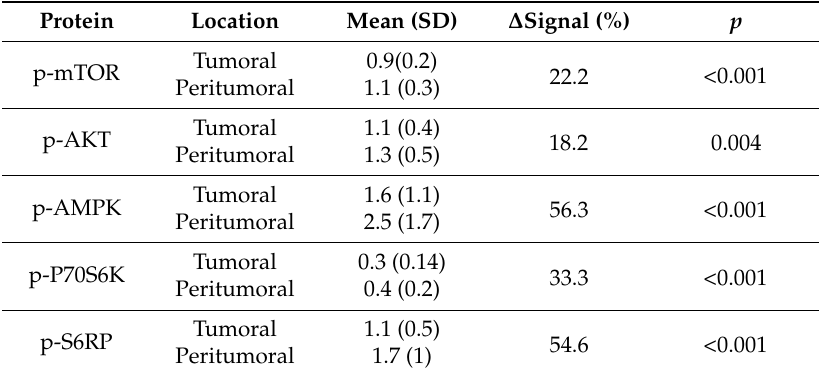
Table 2. Protein expression in tumoral and peritumoral tissue (I/mm 2 ). Abbreviations: SD: standard